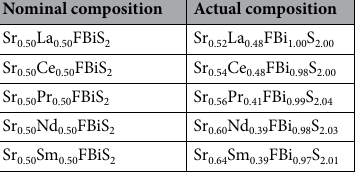
Nominal composition Actual composition